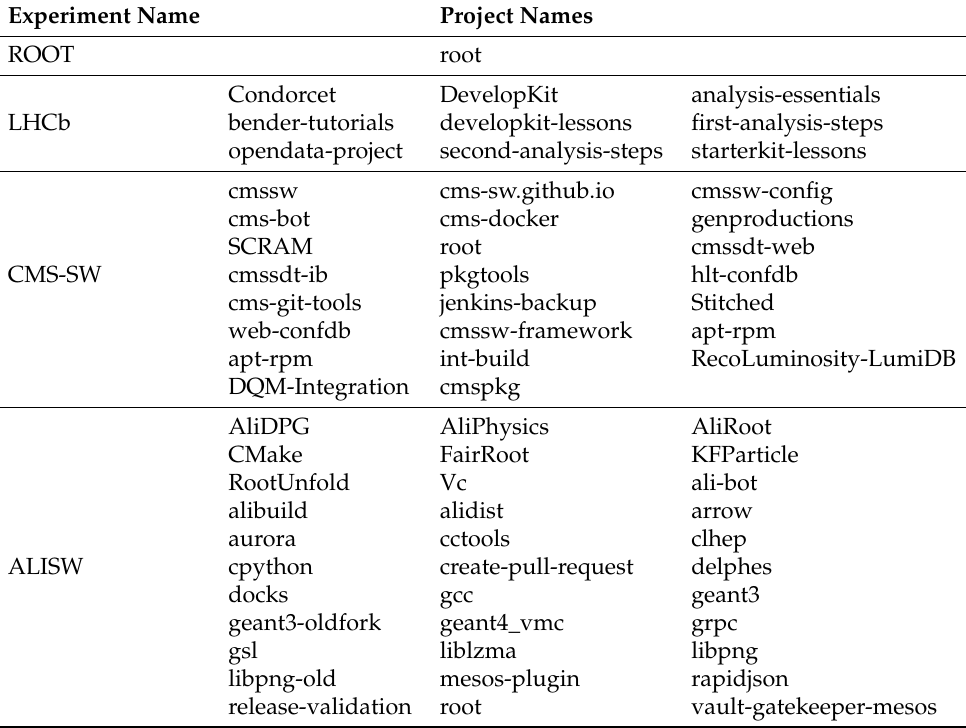
Table 1. Projects in HEP experiments, i.e., ALISW, LHCb, CMS-SW, and ROOT.